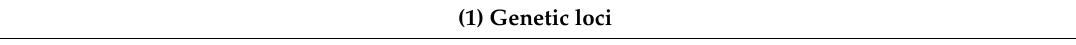
Table 2. Genetic loci and intestinal microflora involved in the pathogenesis of IgG4-related autoimmune pancreatitis